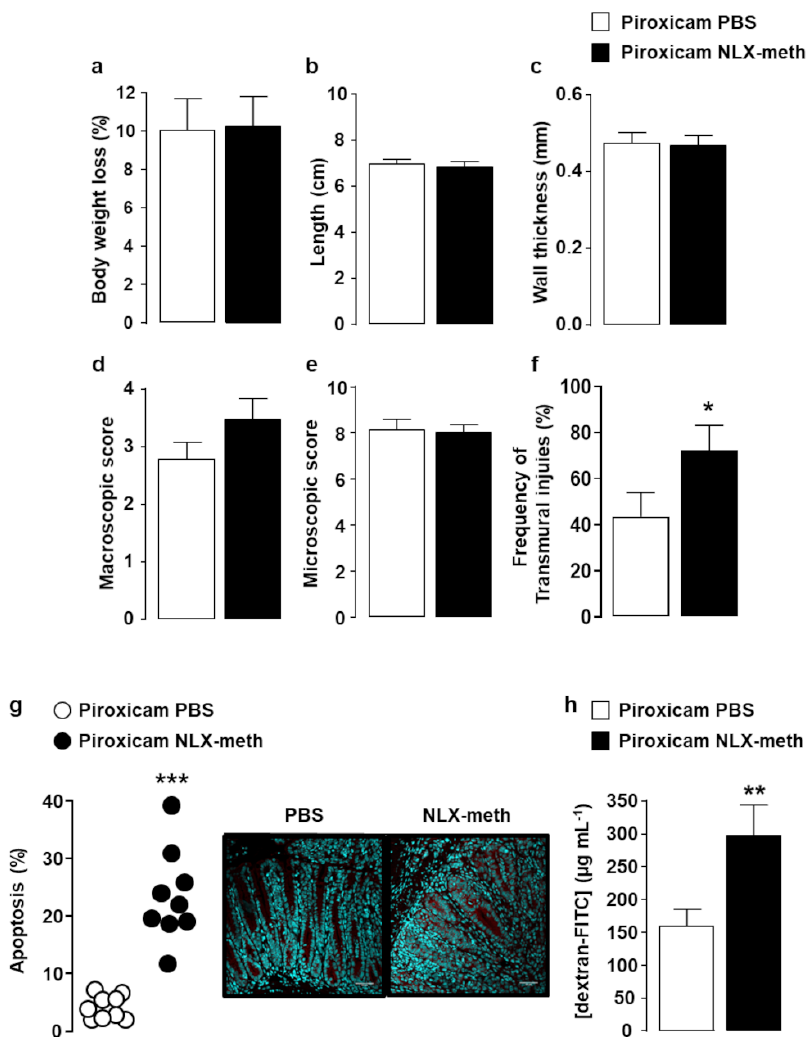
Figure 4. Effects of peripheral opioid receptor blockade on colitis severity in piroxicam-treated IL- 10 -/- mice. IL10 -/- mice were injected with PBS (white symbols) or naloxone-methiodide (NLX-meth, 2 mg) (black symbols) two days apart for the ten days of piroxicam treatment ( n = 17–20/group). Colitis parameters included percent of body weight loss ( a ), colonic length ( b ), wall thickness ( c ), both macroscopic ( d ) and microscopic ( e ) colonic tissue damage including the percentage of transmural colon injuries ( f ). Epithelial apoptosis identified with anti-activated caspase 3 antibodies was quantified relative to epithelium surface (( g ) left panel, each symbol represents 1 mouse). A representative immunohistological staining of apoptotic epithelial cells is shown in the right panel. Paracellular permeability expressed as the mean of FITC-dextran concentration in serum (µg mL −1 ) 4 h after gavage with dextran ( n = 10–13/group) is depicted in ( h ). Data are expressed as mean ± SEM. Statistical analysis was performed using the Mann-Whitney U test.* p < 0.05, ** p < 0.01, *** p < 0.001.